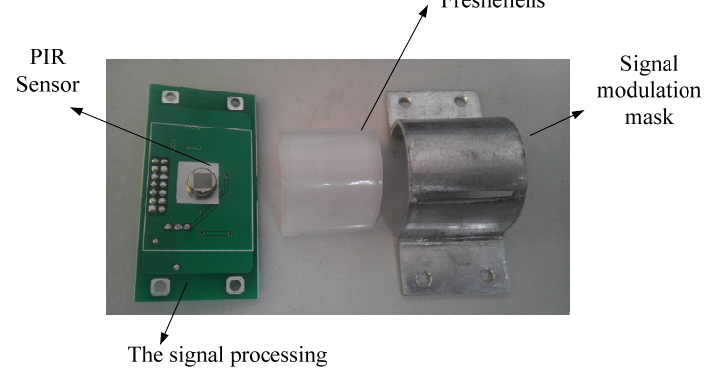
Figure 1. A pyroelectric infrared sensor module is covered by Fresnel lens and signal modulation